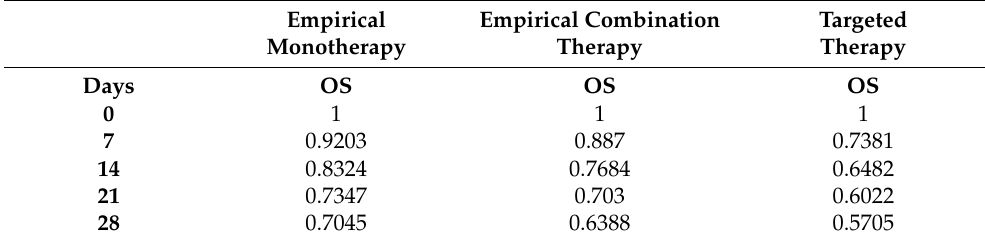
Table 3. Log-rank test for equality of survivor functions, p -value = 0.0399. Empirical Empirical Combination Monotherapy